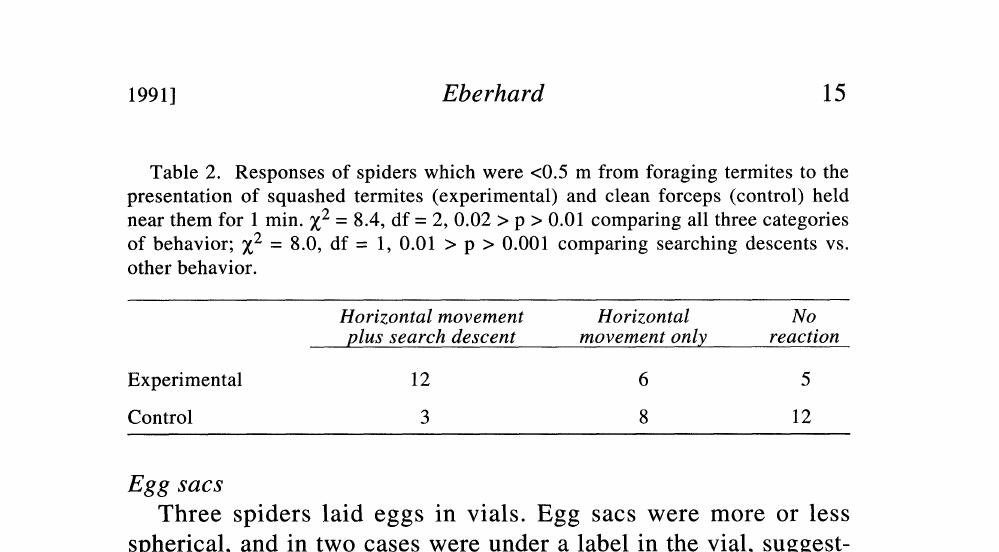
Table 2. Responses of spiders which were <0.5 m from foraging termites to the presentation of squashed termites (experimental) and clean forceps (control) held near them for min. Z 2 8.4, df 2, 0.02 > p > 0.01 comparing all three categories of behavior;